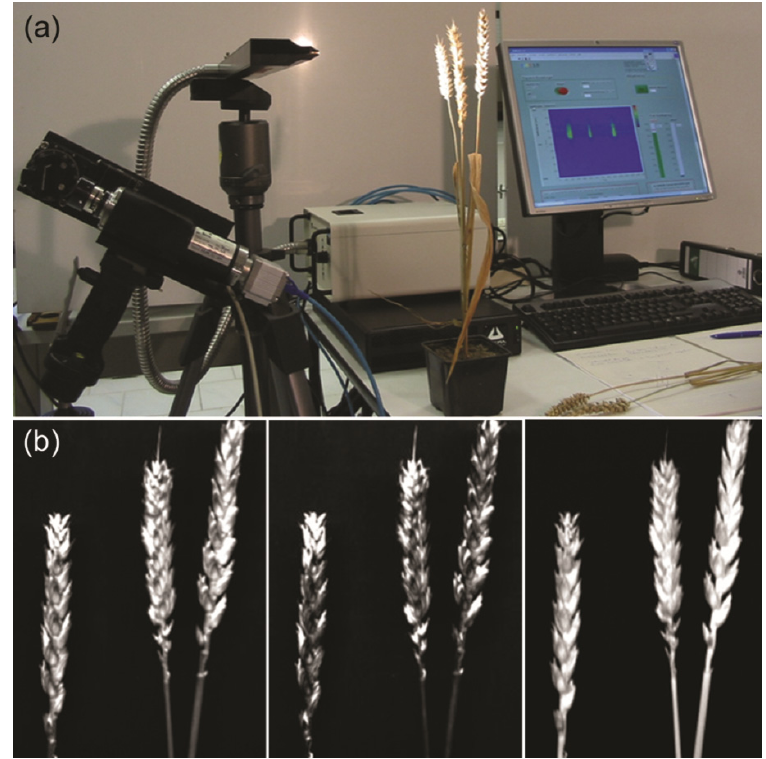
Figure 5. ( a ) Hyperspectral image scanner; ( b ) Reflexion images of a Fusarium -infected wheat sample at different spectra channels (from left to right: red: 550 nm, green: 685 nm, blue: 765